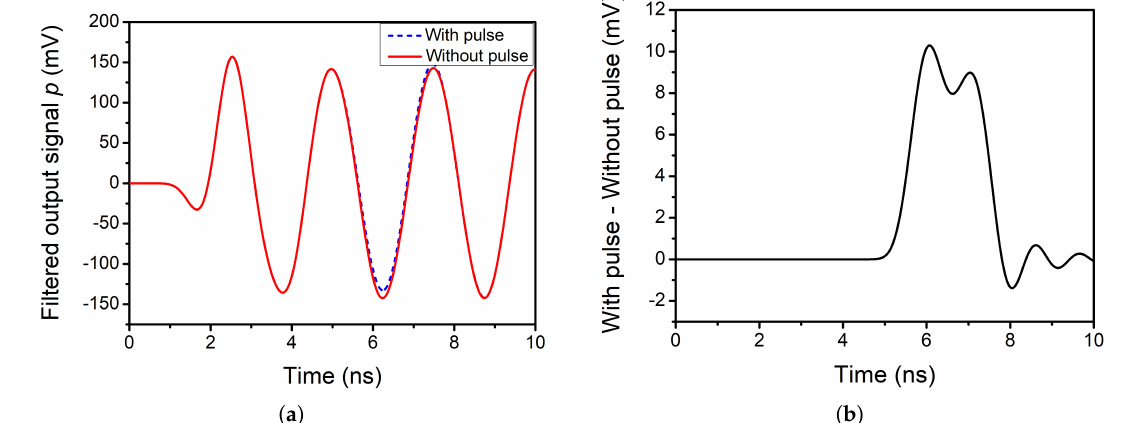
Figure 7. ( a ) Filtered single-ended positive output of the double-balanced mixer with 25% duty cycle when there is a pulse at the input ( τ = 2 ns) and when there is no pulse. ( b ) Effect of the pulse on filtered single-ended positive output of the mixer with 25% duty cycle when there is a pulse at the input ( τ = 2